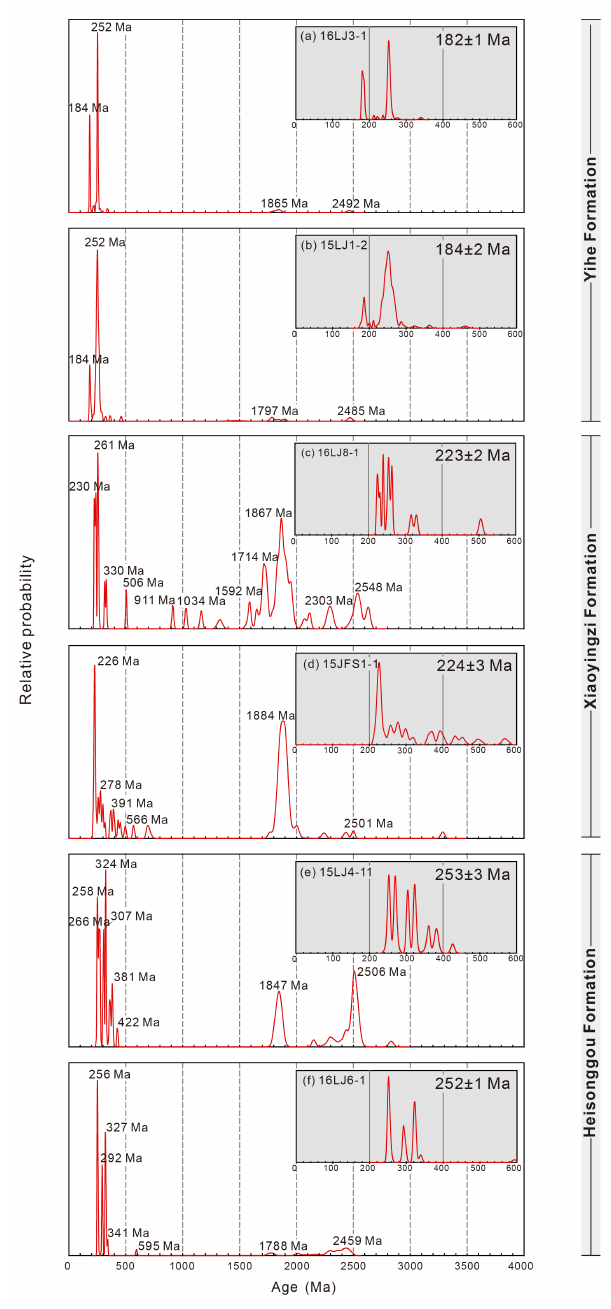
Figure 12. Relative probability diagram of detrital zircon grain ages from early Mesozoic strata of the northeastern